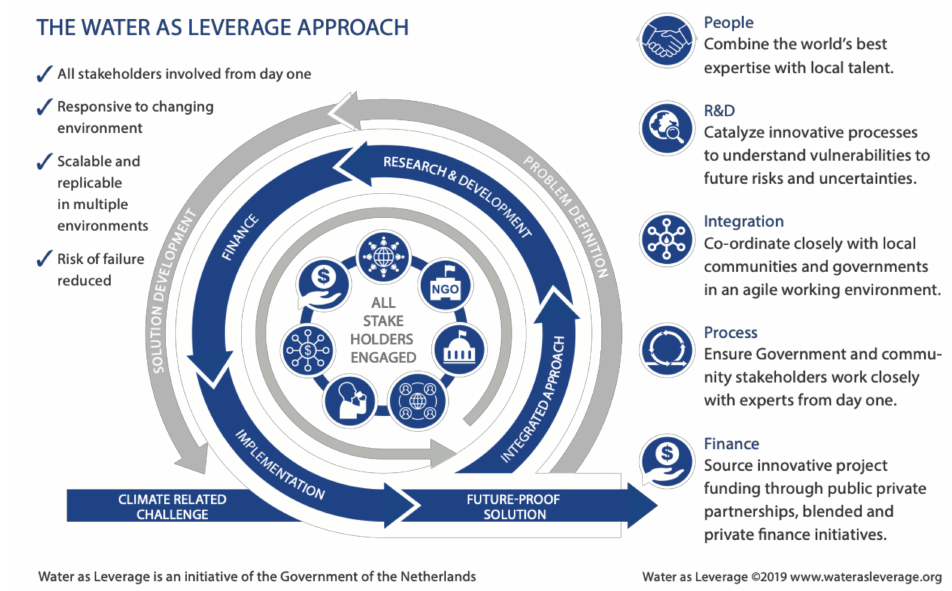
Figure 3. Water as Leverage Approach (Source: Water as Leverage program